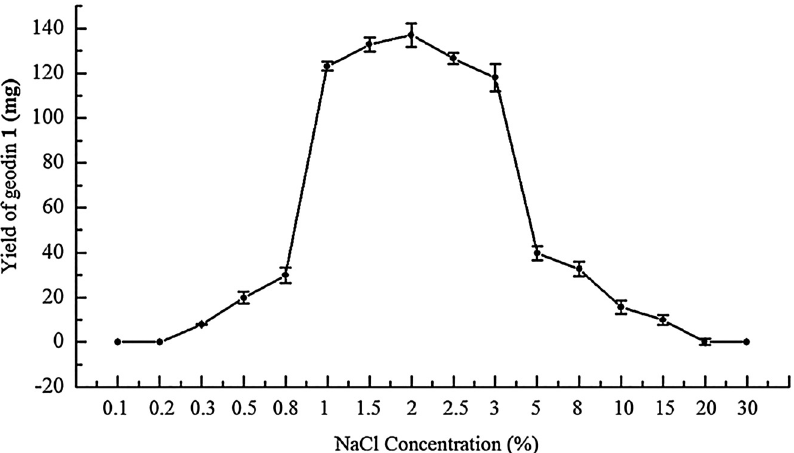
Figure 2: The yield of geodin 1 at various concentrations of NaCl after 3 weeks of incubation at 25 ° C.